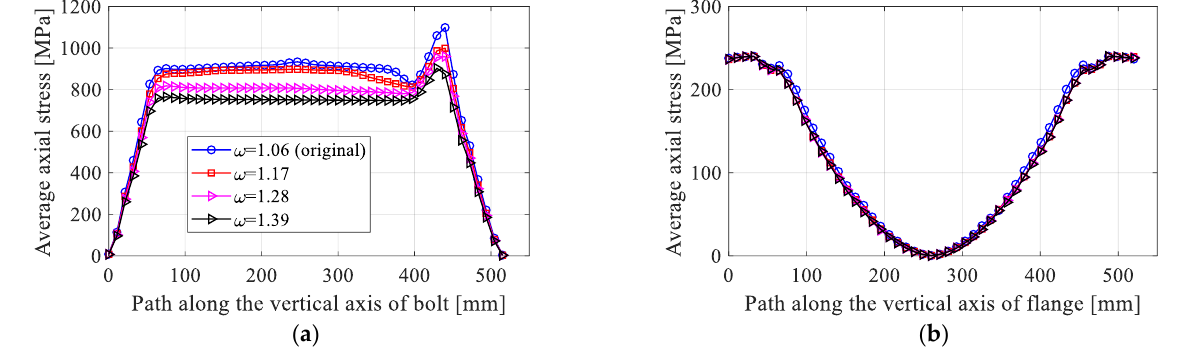
Figure 10. Influence of aspect ratio on stress distributions: ( a ) bolt and ( b ) flange.